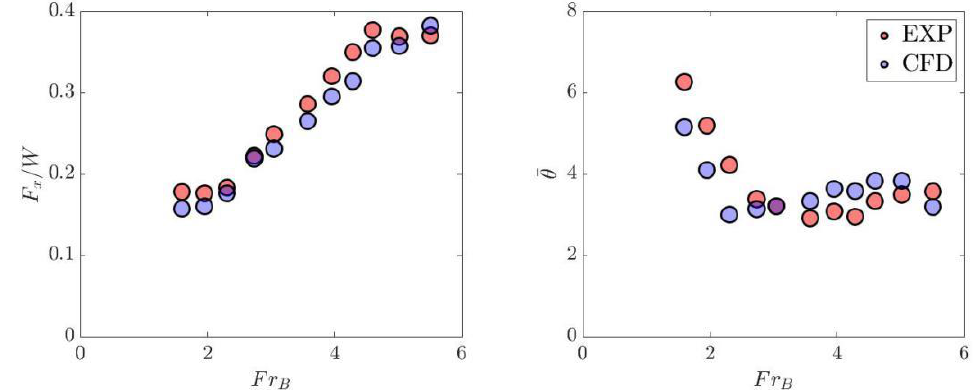
Figure A1. Resistance ( left ) and dynamic trim angle ( right ) of Model B in calm-water conditions. The CFD data and experimental measurements of [12] are presented in the Figure.